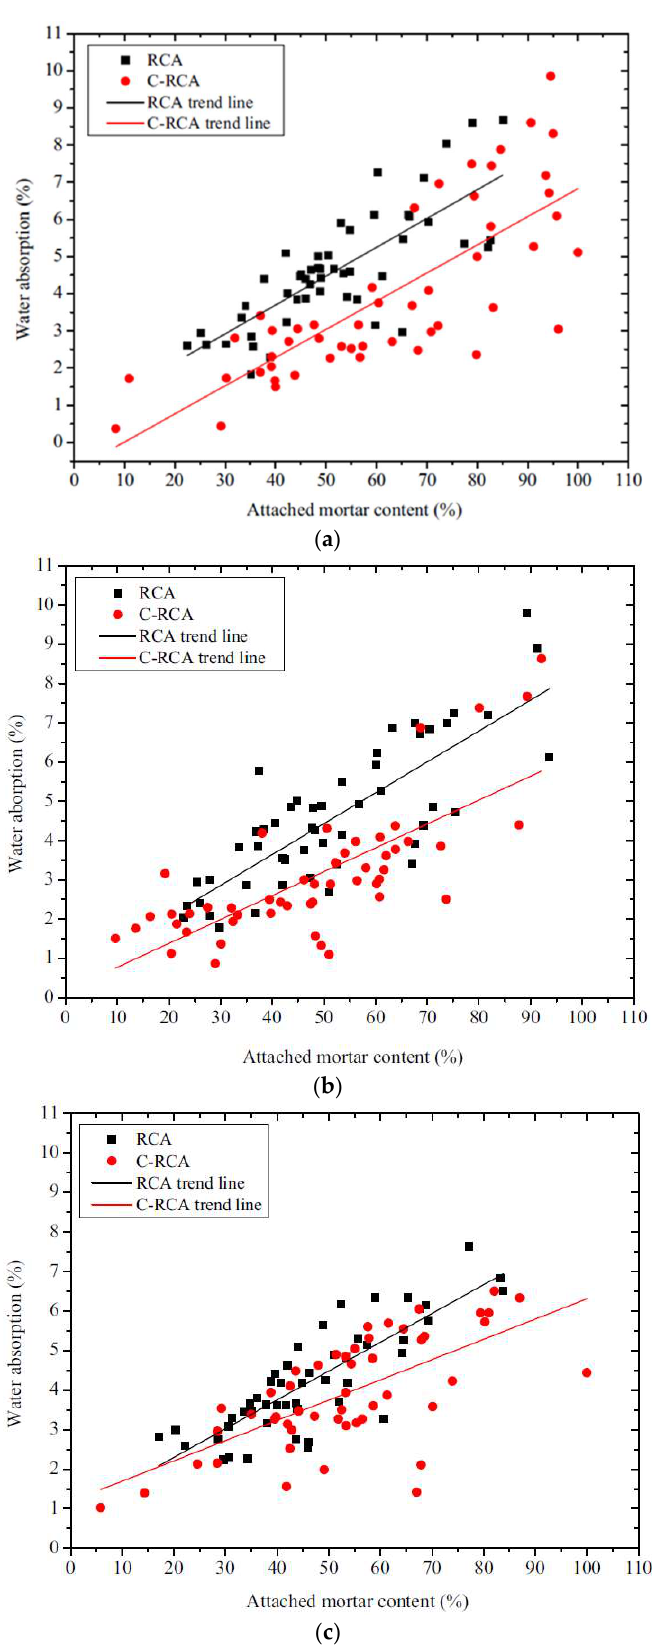
Figure 21. Relation between attached mortar content and WA with particle sizes ( a ) 20–30 mm; ( b ) 30–40 mm; ( c ) >40 mm [6]. Reproduced with permission from [6], Elsevier,